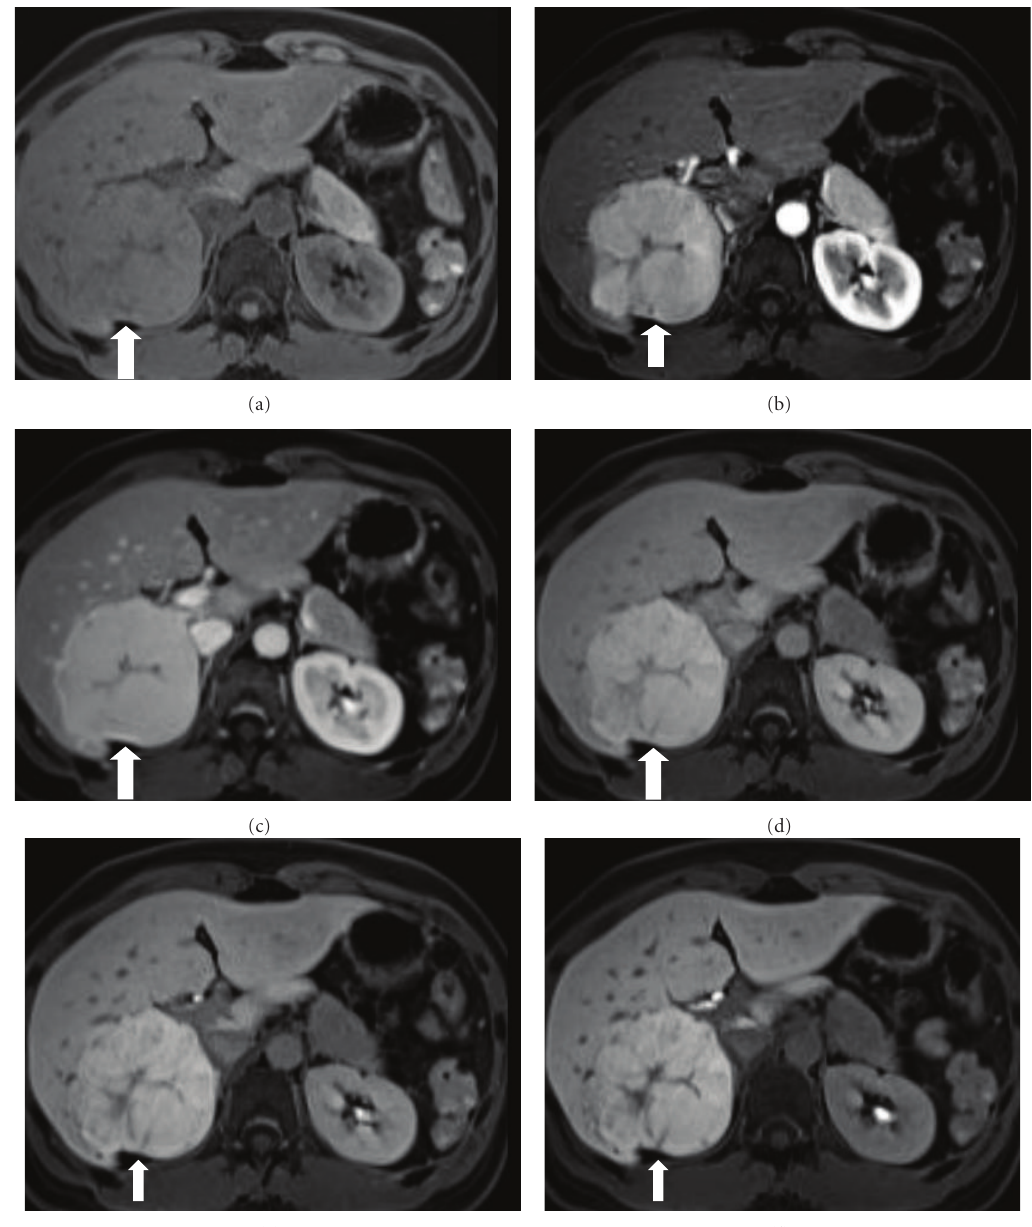
(f) Figure 4: (a–d) Gadoxetate acid-enhanced MRI in the precontrast, arterial, venous, and equilibrium phases of 37-year-old female non- Hepatitis B or C virus carrier showing a large mass in the right lobe of the liver with early arterial enhancement and persistent late-phase enhancement with a small central hypointense scar. (e, f) Gadoxetate acid-enhanced MRI in the hepatobiliary phase 10–20 minutes after injection showing progressively hyperintense enhancement, in a homogeneous pattern apart from the hypointense small central scar. The MRI findings are typical for focal nodular